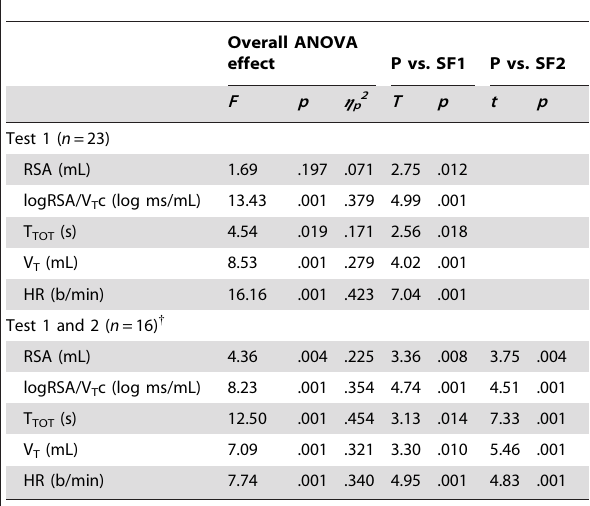
Table 3. Overall ANOVA time effects (df =4,66 or 2,44) for changes in physiological parameters across Still-Face Tests and paired t-tests (df =15 or 22) testing changes from Play to Still-Face episodes 1 and 2.